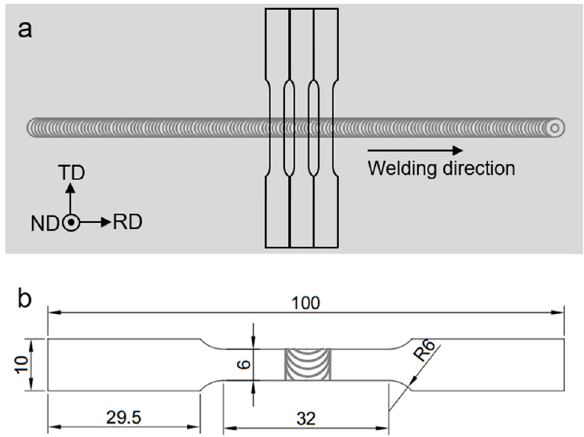
Figure 2: ( a ) Selected location of tensile specimens for 2195 - T8 FSW joint, and ( b ) con fi guration and dimensions of the tensile specimen ( unit: mm ) .